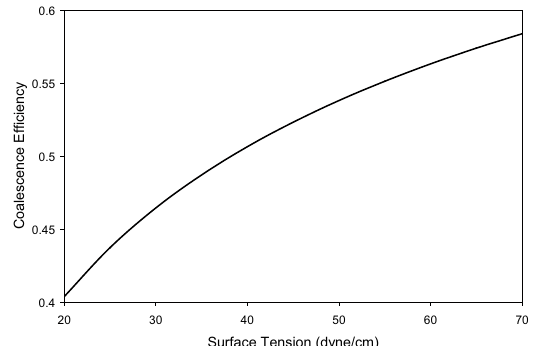
Table 1. Physical properties of different solutions used in the experiments Viscosity Solution (cP) Figure 3. A schematic of the setup and bubble column used in the study.